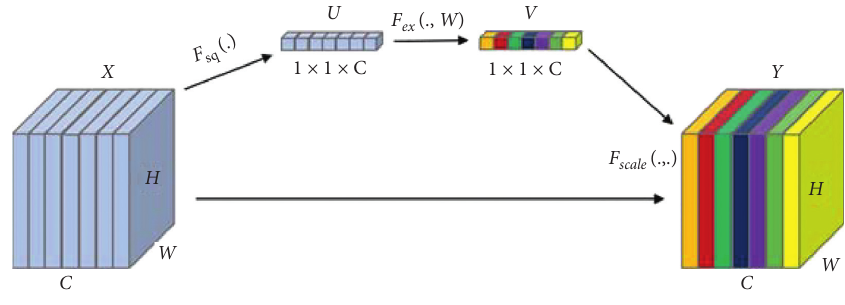
Figure 3: SE Block.